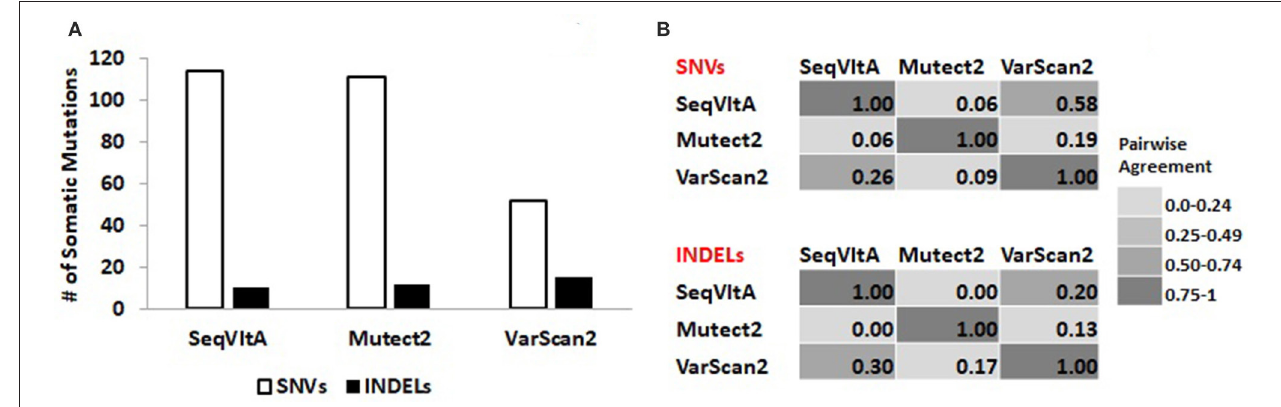
FIGURE 8 | (A) Total number of somatic variants called and (B) Pair-wise agreement (0–1 scores) between SNVs and INDELs predicted by SeqVItA, Mutect2, and